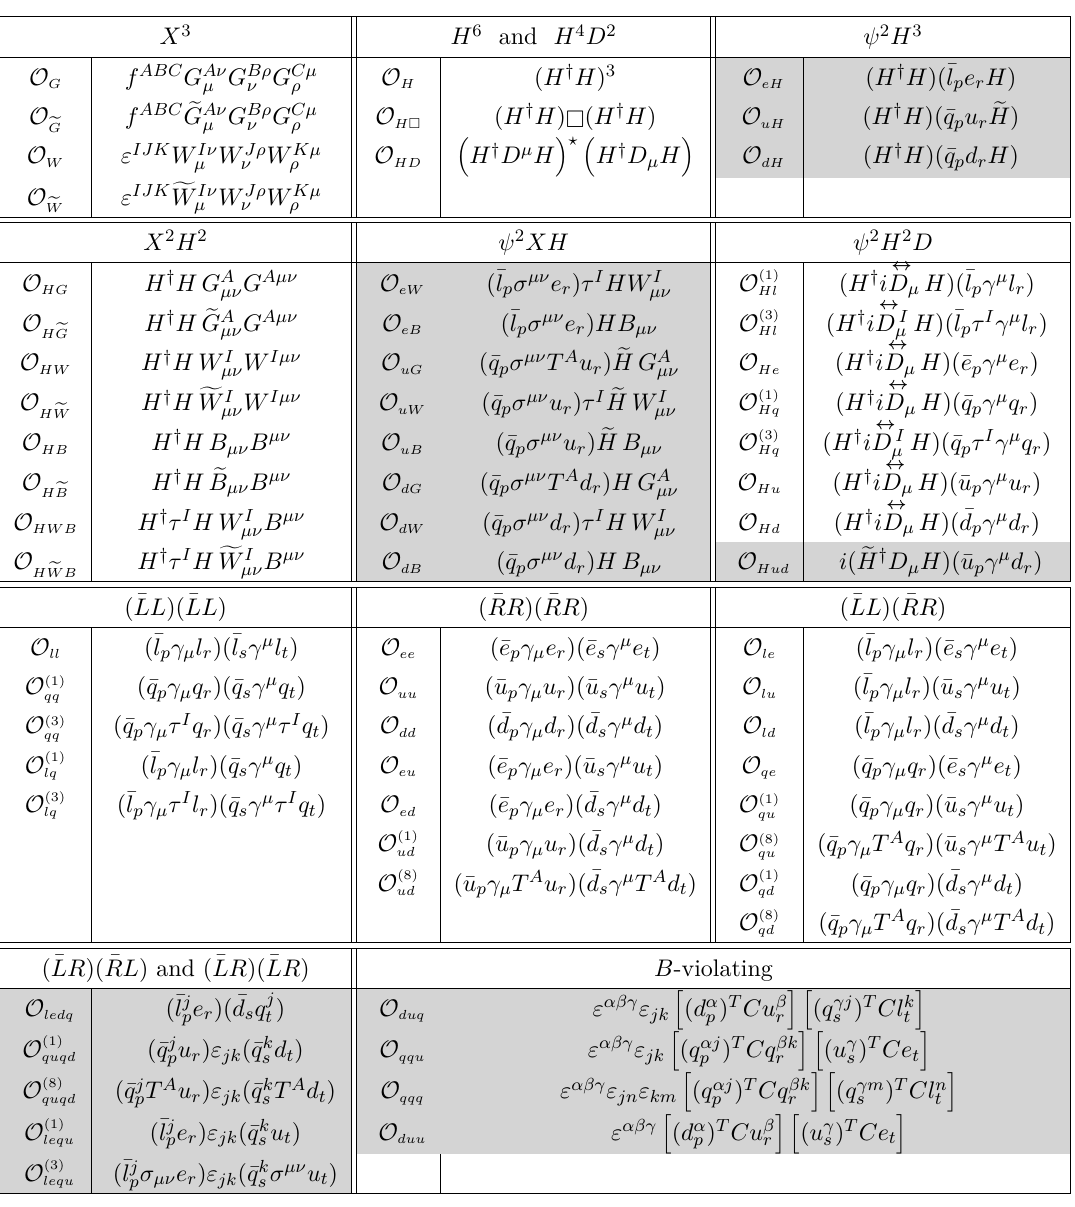
Table 1 . Dimension-6 operators in the Warsaw basis, adapted from ref. [81]. The grey cells indicate operators that break flavour SU(3) 5